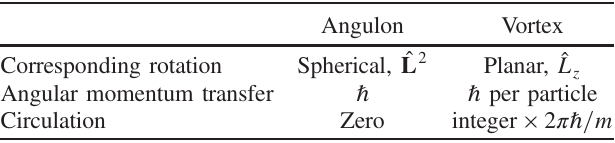
TABLE I. Comparison of the angulon instability with the vortex instability.